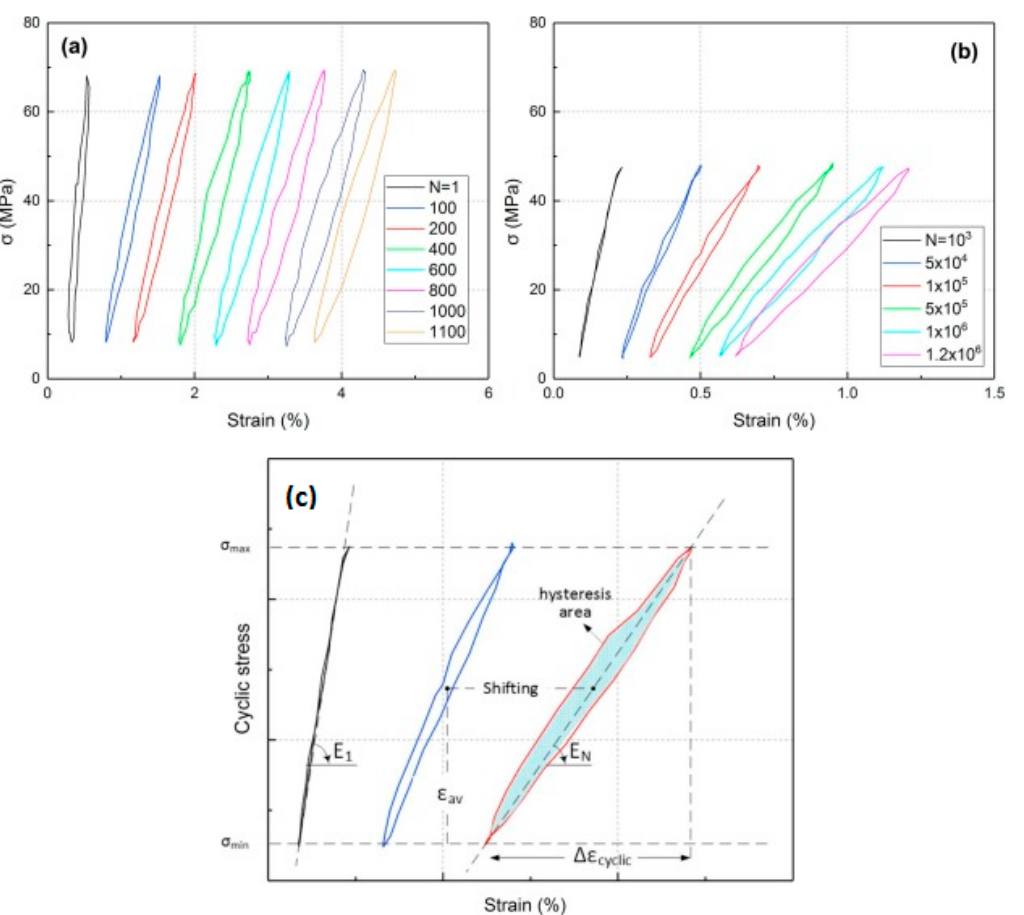
σ = σ = Figure 18. Hysteresis area alteration ( a ) applied to max 68 MPa and ( b ) max 47 MPa Figure 18. Hysteresis area alteration ( a ) applied to σ max = 68MPa and ( b ) σ max = 47MPa and and ( c ) slope variation as the result of an increase in the number of cycles [77]. ( c ) slope variation as the result of an increase in the number of cycles, adapted with permission from Ref. [77]. Copyright © 2018 Elsevier